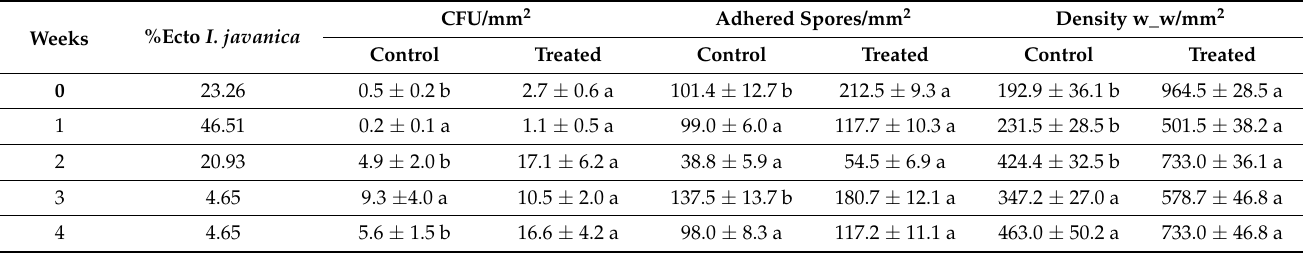
CFU: colony-forming units. Treated: fungus-treated. ± : Standard error value. %Ecto I. javanica : percent of I. javanica pf185 found among the white ectophytic fungi. For the same parameter, means for control and fungus-treated leaves followed by different letters are significantly different ( p <